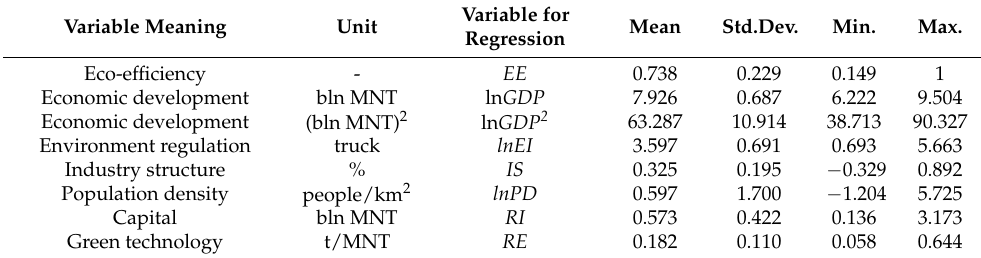
Table 3. Variables selection of driving factors and descriptive statistics. Variable Meaning Unit